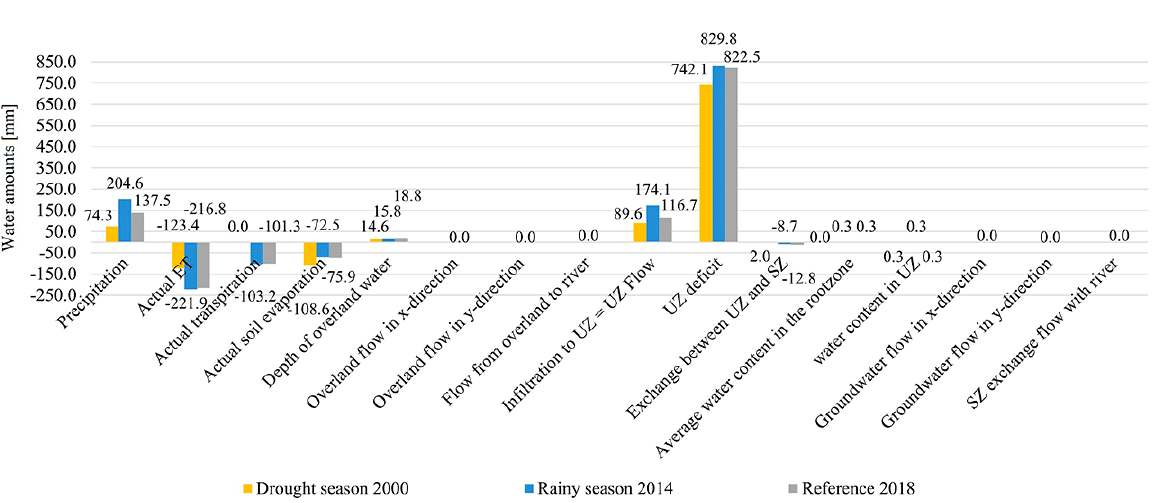
Figure 9. Average of simulated hydrological parameters from 1 March to 31 May in the drought year 2000, the rainy year 2014 and the reference year